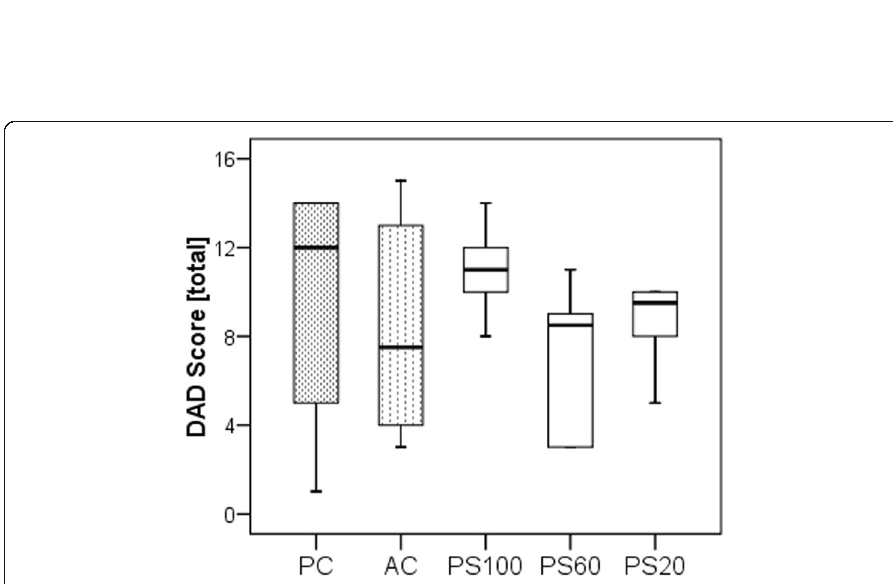
Fig. 2 Diffuse alveolar damage (DAD) total score after 4 h of ventilation in pressure control (PC), assist control (AC), or pressure support ventilation with 100%(PS100), 60%(PS60), or 20%(PS20) of previous pressure control level. Differences among groups were not statistically significant ( p =